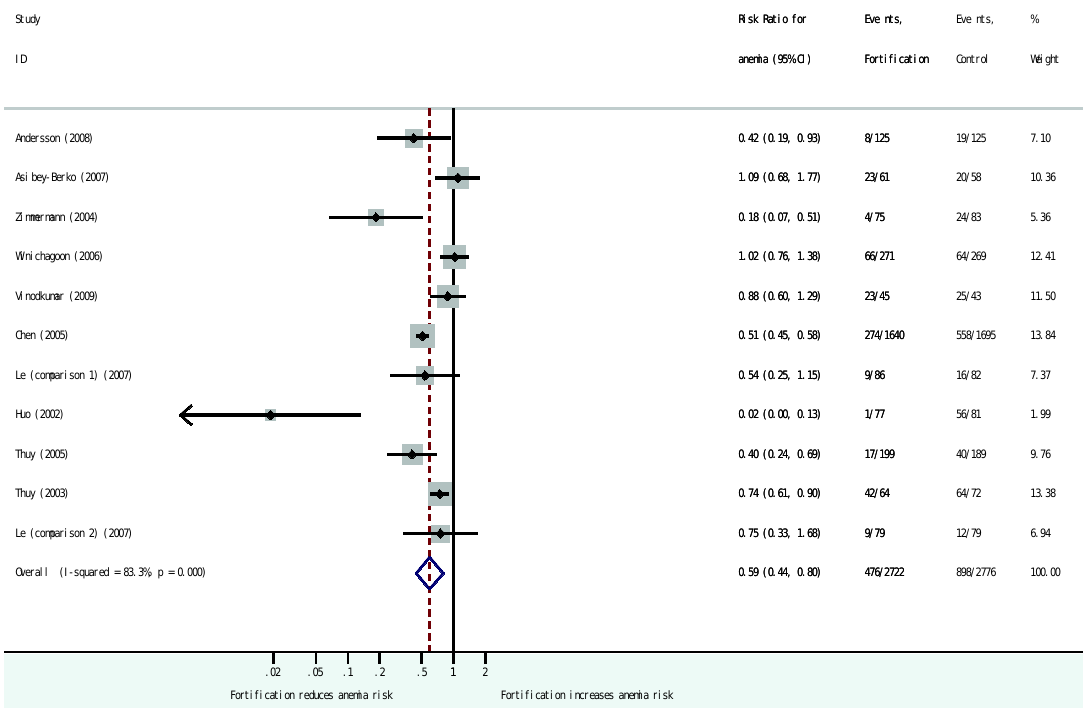
Figure 3. Effect of fortified condiments and noodles on anemia rate compared to non- fortified condiments or noodles. Included are 10 studies with 11 comparisons. Results are provided as risk ratio (RR, 95%-CI) of suffering from anemia in the intervention group compared to the control group.